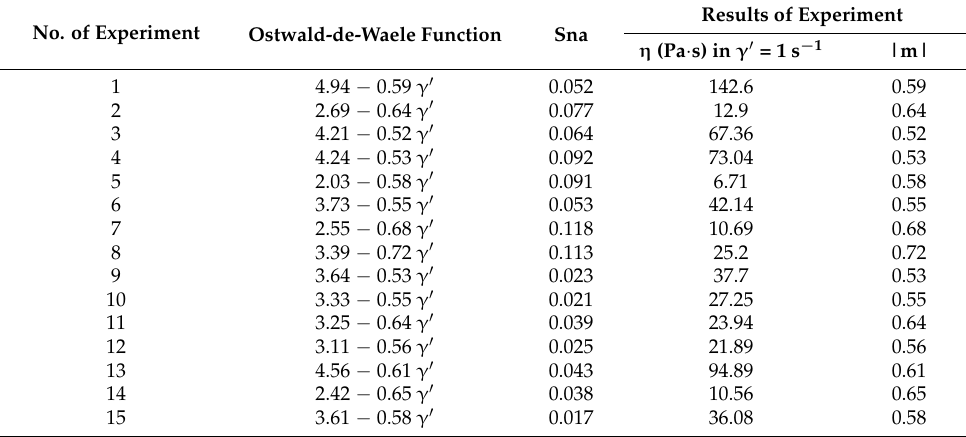
Table 3. Results of experiment.